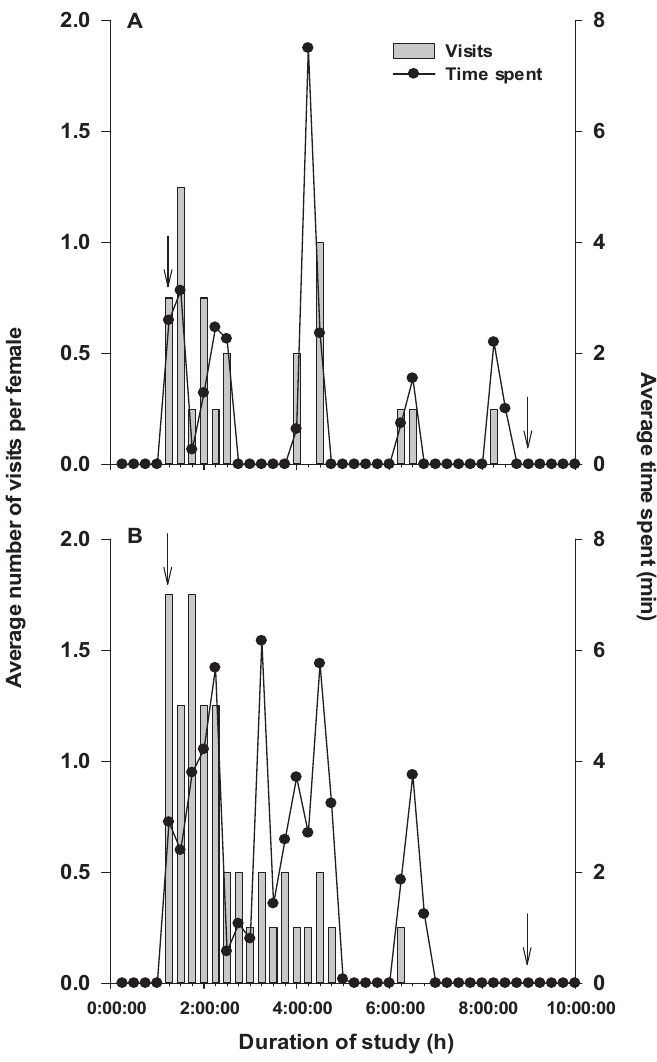
Figure 6. Mean number of visits (bars) and mean time spent on a food source (dots) by Plodia interpunctella during day 1 ( A ); and day 2 ( B ), recorded in Study 3. Each 10-h recording period for each day is divided into 40 consecutive 15-min intervals, and each bar or dot represents an average of observations for four females. Time interval between the downward-pointing arrows in each figure panel represents the duration of the scotophase. Standard errors for mean visits and mean time spent per 15-min interval were between 0–1.44 and 0–4.33 min, respectively.